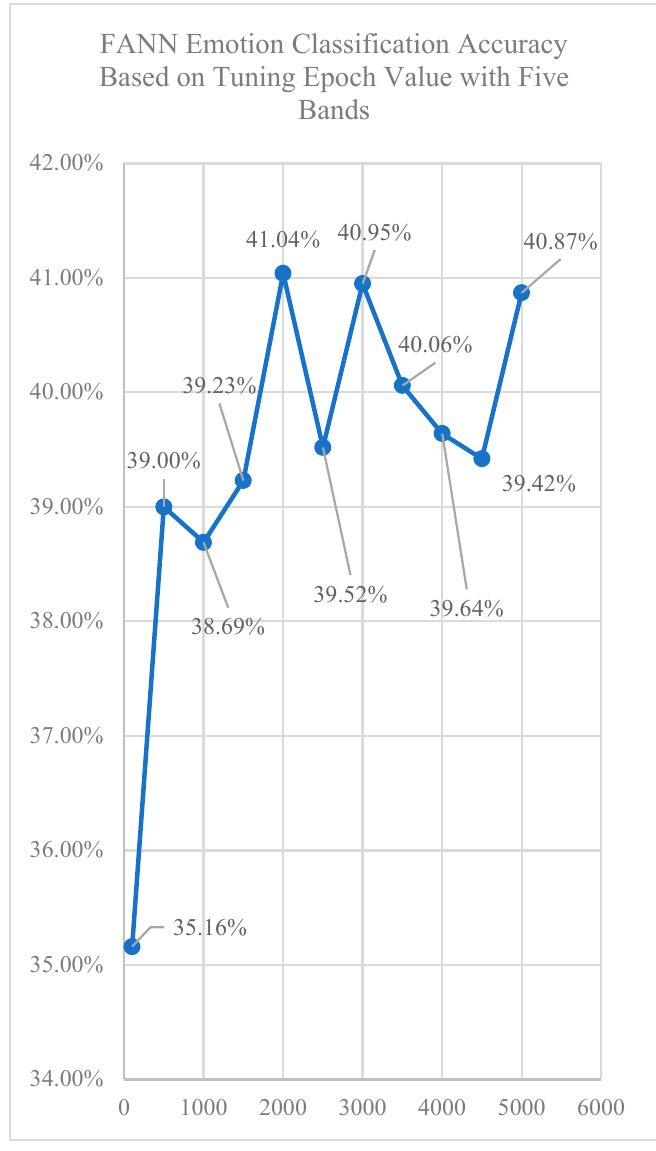
Figure 5. Inter-Subject FANN Classification Result using Five Bands. In Figure 6, the results for KNN, SVM, and FANN using the default parameter config- urations are shown. By comparing the results shown in this figure, the class weight kernel from SVM obtained the best classification results, i.e., 75.90% using the linear interpolation method and 75.61% using the spline interpolation method. This was followed closely by KNN achieving a classification accuracy of 75.55% using linear interpolation method and 75.43% using spline interpolation. Despite the complexity of adopting the inter-subject variability approach, the classification accuracy achieved from the two classifiers was acceptable for a four-class classification